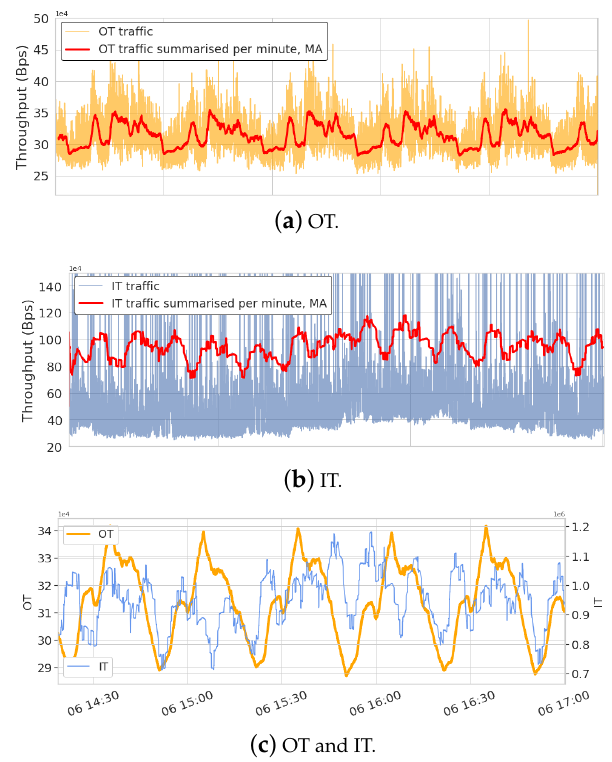
Figure 7. Production cyclic work-flow projected from network